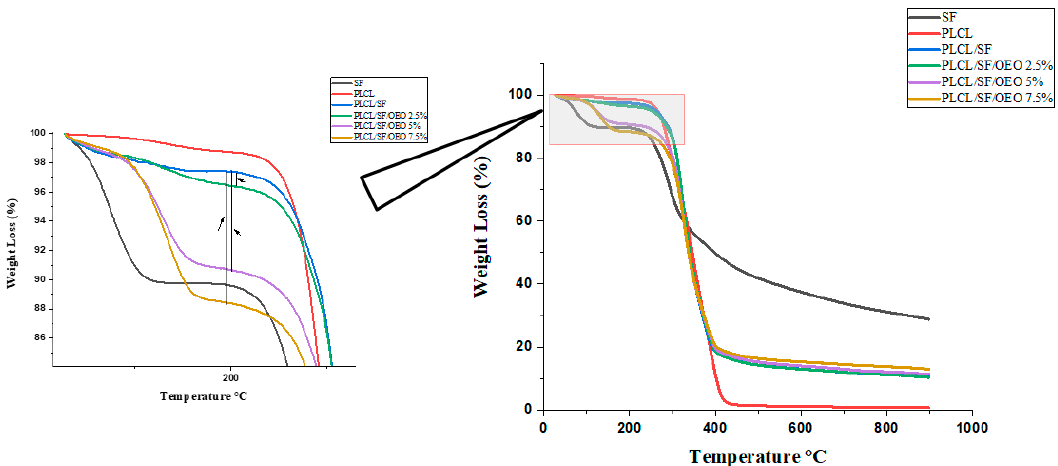
Figure 4. Thermogravimetric Analysis (TGA) graph of pure SF, PLCL and electrospun NF membranes with OEO (0%, 2.5%, 5% and 7.5%). Table 2. Thermogravimetric Analysis of SF, PLCL and Electrospun Membranes Loaded With OEO.